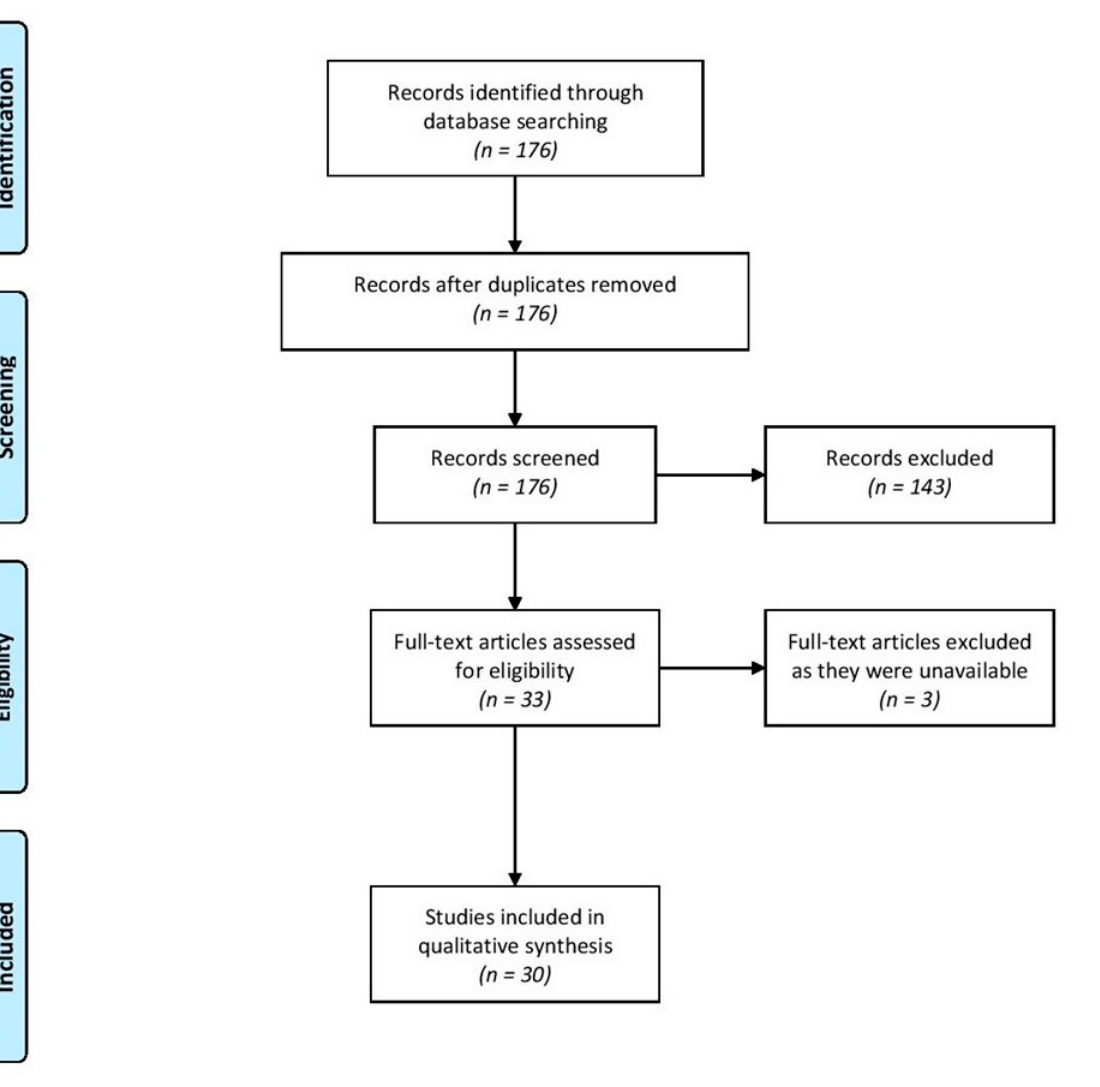
Figure 1. PRISMA Diagram.